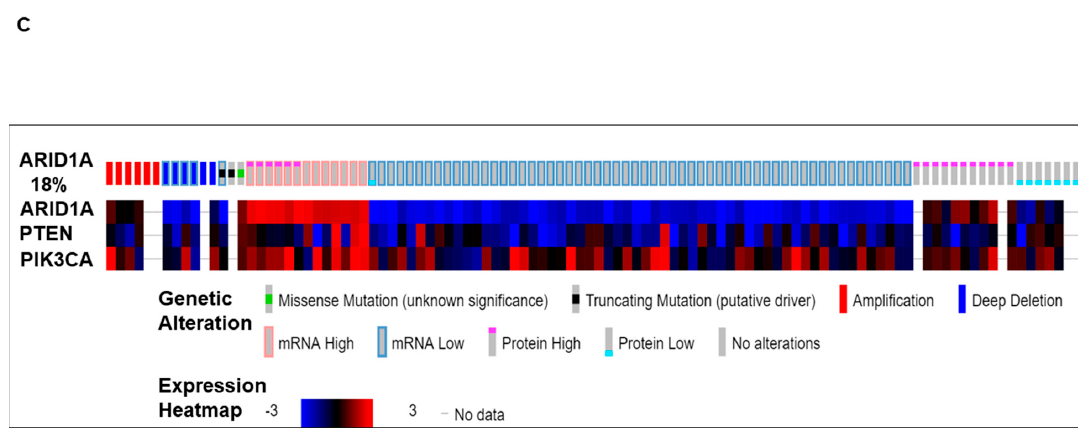
Figure 1. Alterations of ARID1A gene in ovarian cancers. Data has been quarried from cBioPortal (April 2019) representing a study (TCGA Provisional) of 594 patients / 606 samples, (http: // www.cbioportal.org). Quarried gene is altered in 104 (18%) of queried patients [104 (17%) of queried samples]. ( A ) presents Oncoprint showing the alteration frequency of the ARID1A gene in ovarian serous cystadenocarcinoma (TCGA Provisional) with the overall survival status. The color codes for the types of genetic alterations (missense mutation / truncating mutation / amplification / deep deletion / mRNA high / mRNA low / protein high / protein low / no alterations) are presented in the figure. The overall survival status (living, deceased, and no data) is presented as the inset in the figure. ( B ) presents the number of ARID1A mutations (somatic mutation frequency) (Y-axis) plotted on the amino acid (sequence number as X-axis). Protein Changes, Mutation Types, and Copy numbers are presented in the figure. Mutation diagram circles are color-coded with respect to the corresponding mutation types. The green circle represents missense mutations. Black circles represent truncating mutations (Nonsense, Nonstop, Frameshift deletion, Frameshift insertion, and Splice site). ( C ) presents the expression heatmap of ARID1A, PTEN, and PIK3CA in genes in ovarian serous cystadenocarcinoma (TCGA Provisional) representing a study of 594 patients / 606 samples, (http: // www.cbioportal.org). The heatmap was superimposed on the alterations of the ARID1A gene in respective samples. We acknowledge works of Cerami et al. [23] and Gao et al. [24]. We